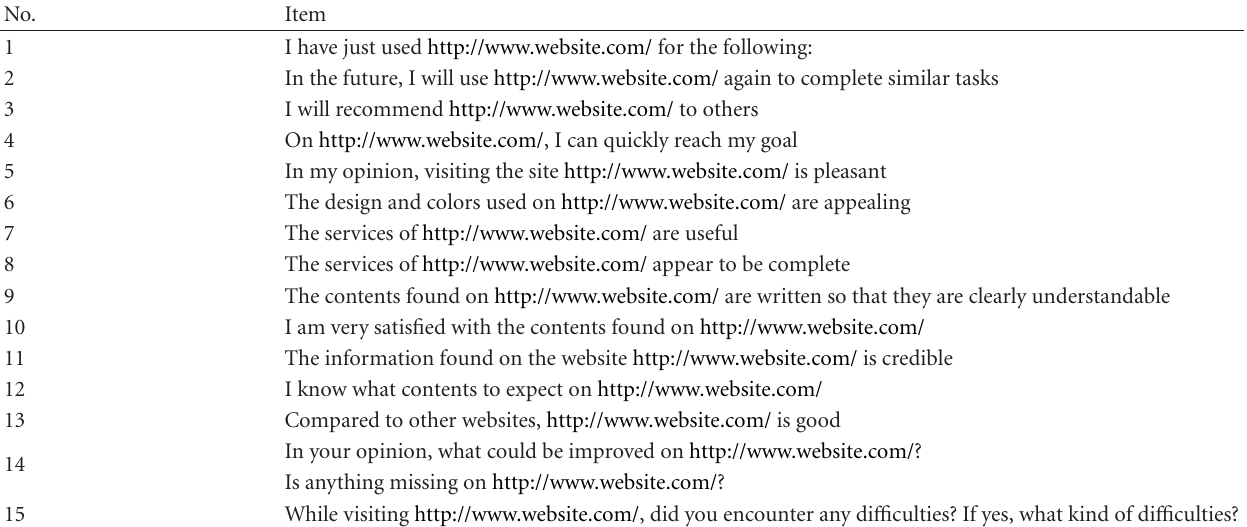
Table 5: Second version of ZeGo (translated by the